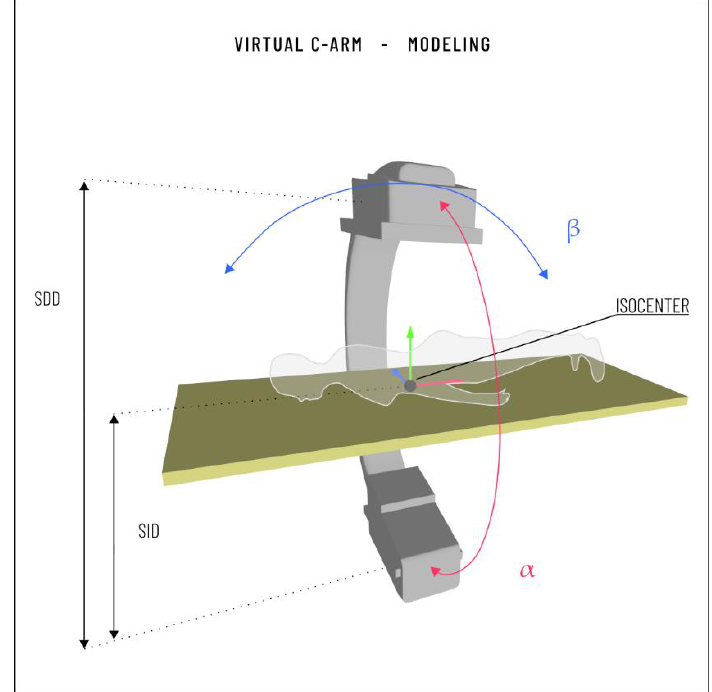
Figure 5. Virtual C-Arm modeling for the Virtual X-Ray Visualization module. The Virtual C-Arm can rotate around its isocenter, adjusting α and β values with keyboard inputs to obtain different image projections.